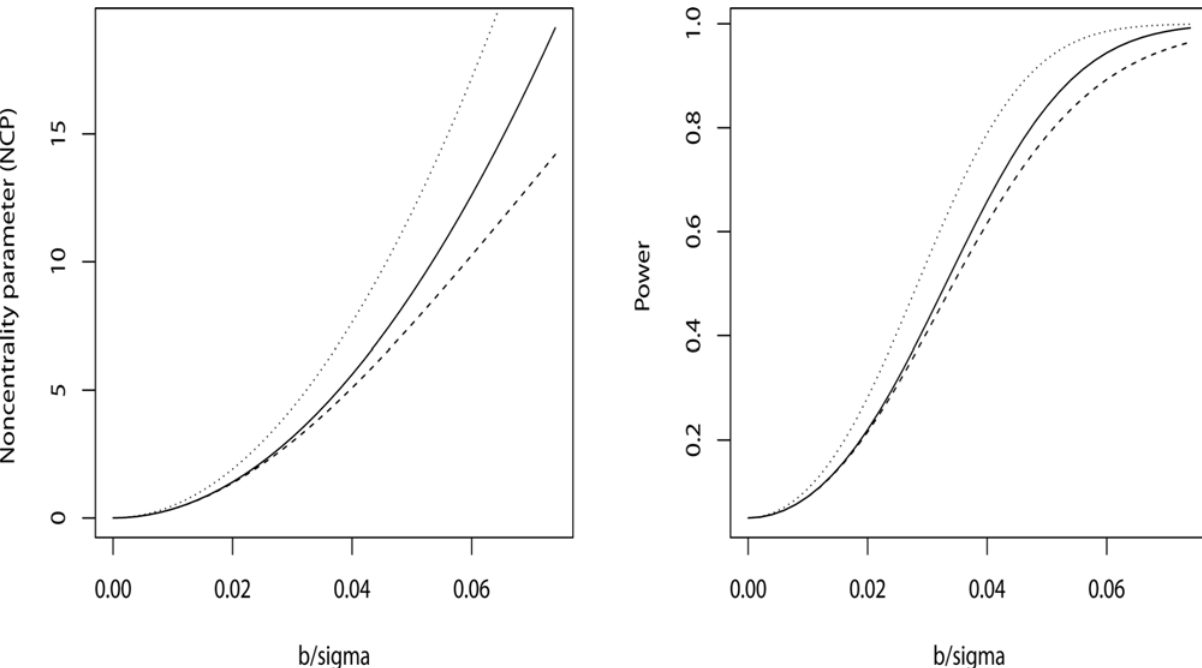
Fig 1. Noncentrality and Power. Points indicate effects assuming no sharing of errors, dashes include the shared error effects. For reference the dotted lines show noncentrality parameters and power assuming that true dose rather than estimated dose was available for the study. Results are particular to the AVS data described